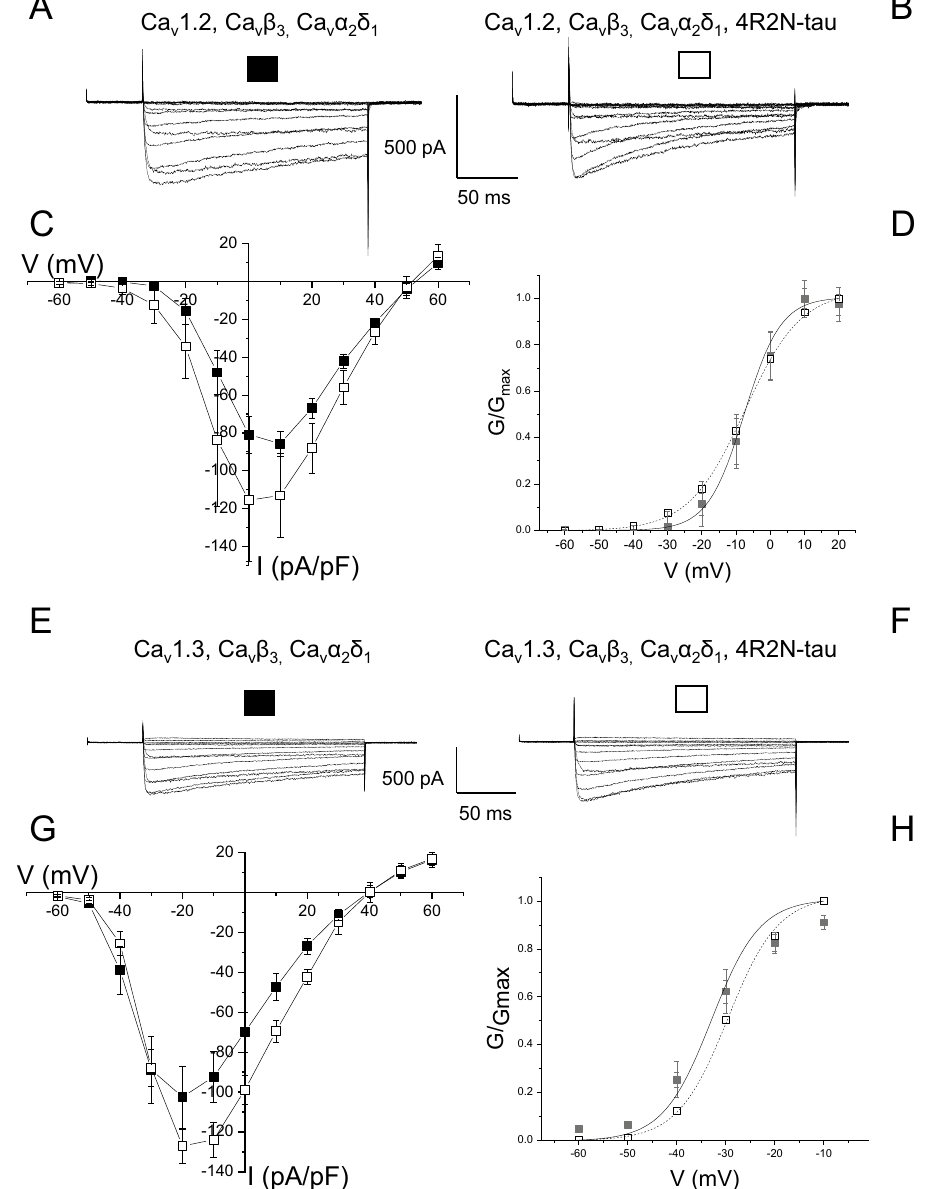
Figure 6. Both Ca V 1.2- and CaV1.3-mediated L-type Ca 2+ current is enhanced by co-expression of 4R2N- tau. ( A ) Representative macroscopic current traces from a tsA-201 cell expressing Ca v 1.2, Ca v β 3 , and Ca v α 2 δ 1 subunits evoked by step depolarizations from a holding potential of − 90 mV. ( B ) Augmented L-type current amplitude observed in cells co-expressing 4R2N-tau and Ca v 1.2, Ca v β 3 , and Ca v α 2 δ 1 subunits. ( C ) The amplitude of expressed Ca v 1.2, Ca v β 3 , and Ca v α 2 δ 1 -mediated current was augmented throughout the voltage range when co-expressed with 4R2N-tau, with no shift in sensitivity to voltage ( D ). ( E , F ) Macroscopic Ca v 1.3, Ca v β 3 , and Ca v α 2 δ 1 -mediated current evoked from a holding potential of − 90 mV, in the absence ( E ) and presence ( F ) of co-expressed 4R2N-tau. ( G ) Current–voltage relationship of Ca v 1.3,Ca v β 3 ,Ca v α 2 δ 1 -mediated current showing co-expression of 4R2N-tau augmented current with a small effect on voltage-dependence of activation. ( H ) Activation curve showing co-expression of 4R2N-tau caused a non-significant shift in voltage sensitivity, with V 0.5 shifting from − 33.2 ± 2.0 mV to − 30.3 ± 1.1 mV (n = 8) (t = − 1.24, p =